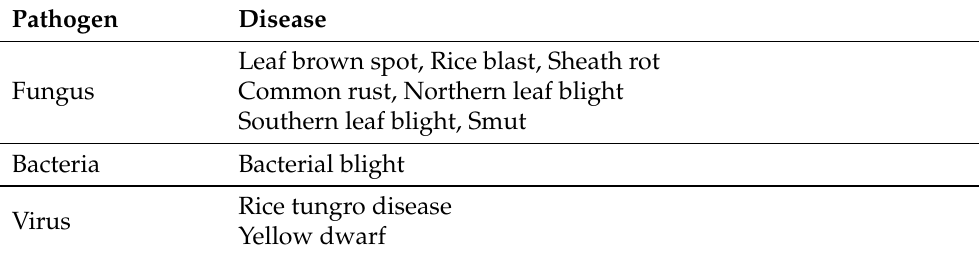
Table 4. Some Rice disease types and causing pathogens